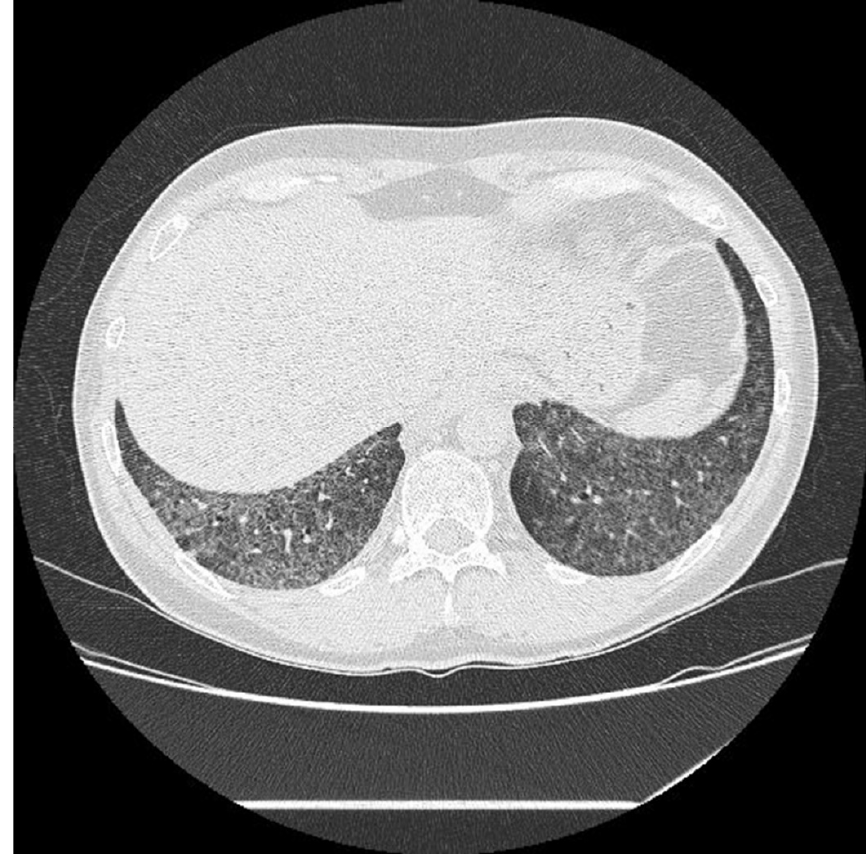
Figure 2. UIP in course of SSc-ILD.